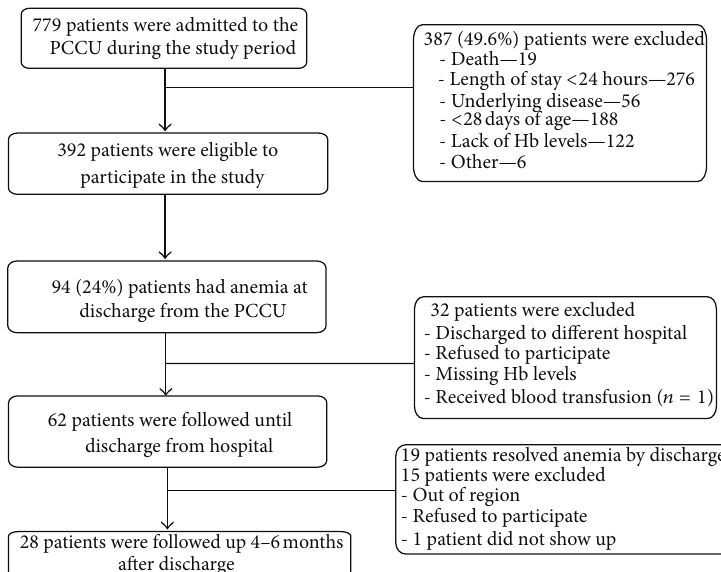
Figure 1: Flow chart of the study.